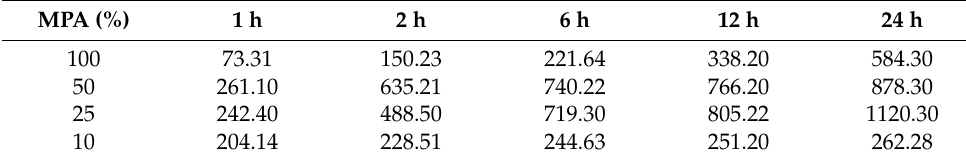
Table 1. ∆ Rct changes at different volume fractions of MPA with